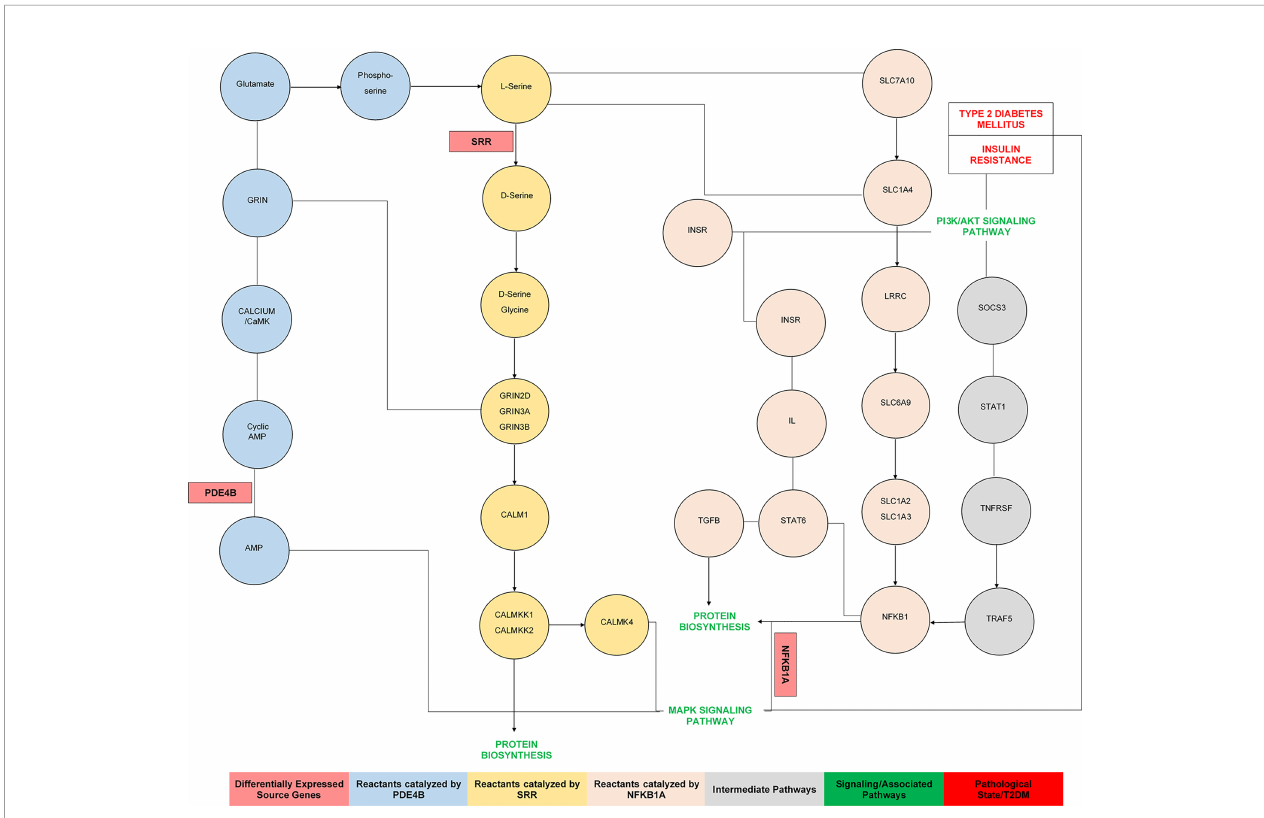
FIGURE 9 | The pathways analysis indicates the mechanism and functional association of source genes involved in the pathophysiology of insulin resistance and type 2 diabetes